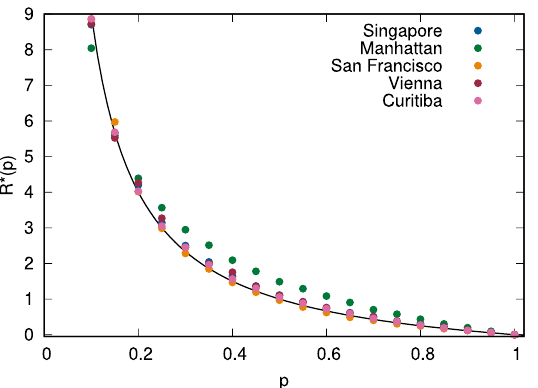
Figure 2. Rescaled average fleet size factor for all cities. All results have been scaled with the best fit D values identified based on the results displayed in Fig. 1.